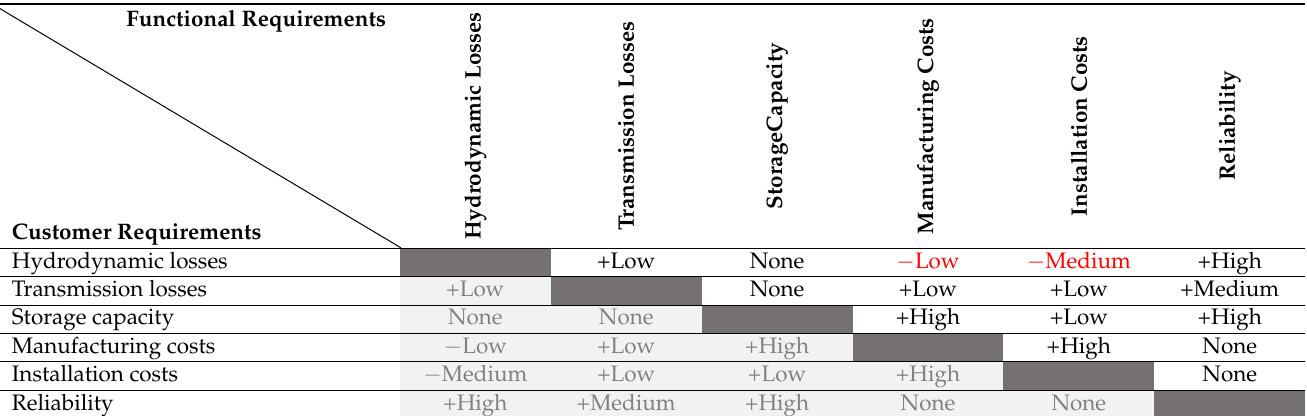
Table 5. Example of assessing interdependence of functional requirements for a tidal developer improving their array, showing the strength of the relationships (high, medium, low, none) and type of correlation (positive/negative). Grey shading used to highlight the symmetric nature of interdependence; Text in red to highlight conflicting